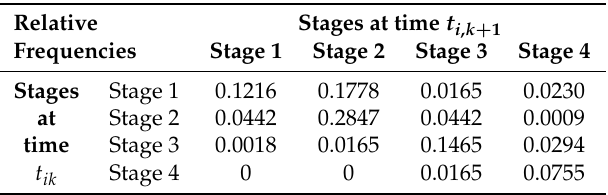
Table 4. Aneurysm data: relative frequencies of transitions between stages of aortic diameter for the observed data.